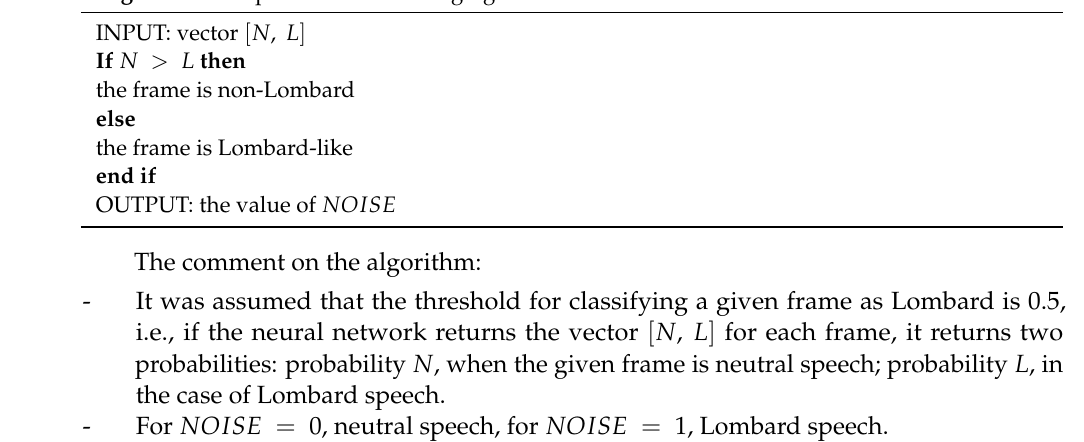
Algorithm 1: A procedure for averaging the Lombard effect detection results.